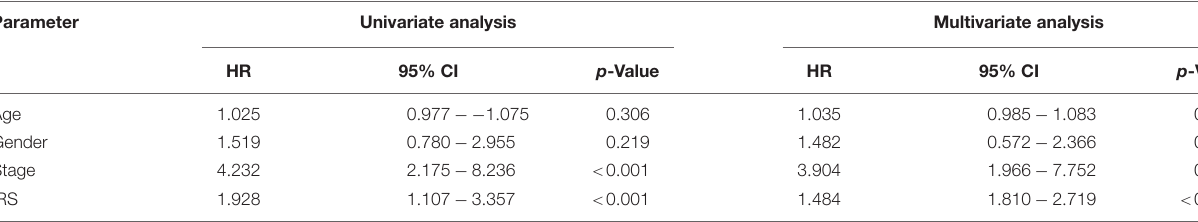
TABLE 3 | The prognostic effect of clinical and molecular parameters in